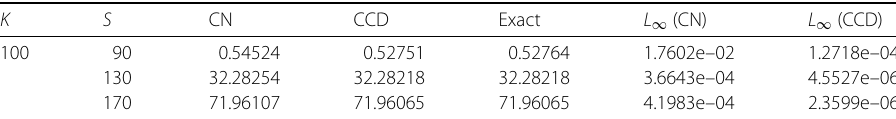
Table 2 A comparison between the approximate solution and the exact solution corresponding to the European call options under the Merton model with λ = 0.1